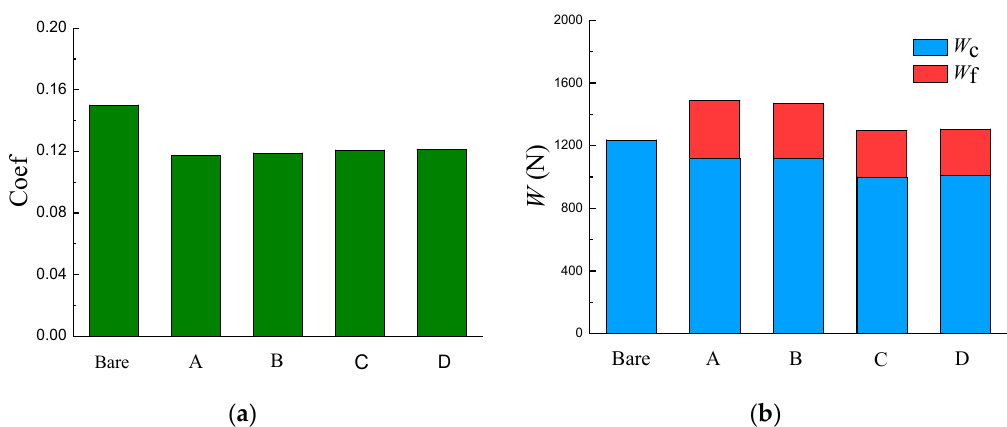
Figure 4. ( a ) Friction coefficient and ( b ) load-bearing capacity of the four typical texture arrangements.